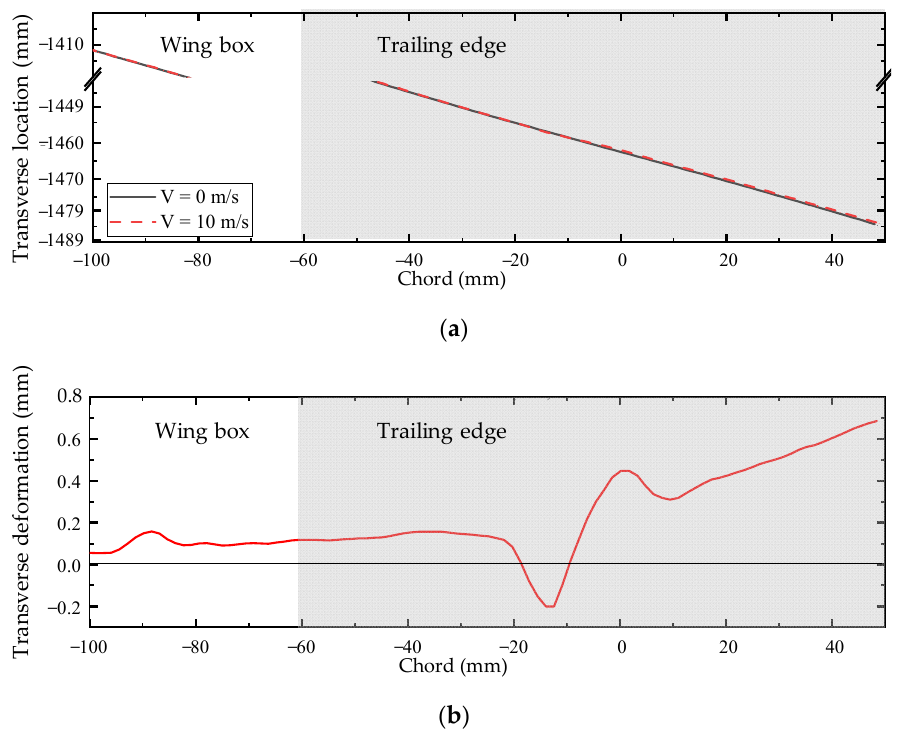
Figure 26. Static aeroelastic deformation of mTE4 (actuation input −30°, AoA 26°). ( a ) Transverse location. ( b ) Transverse deformation.